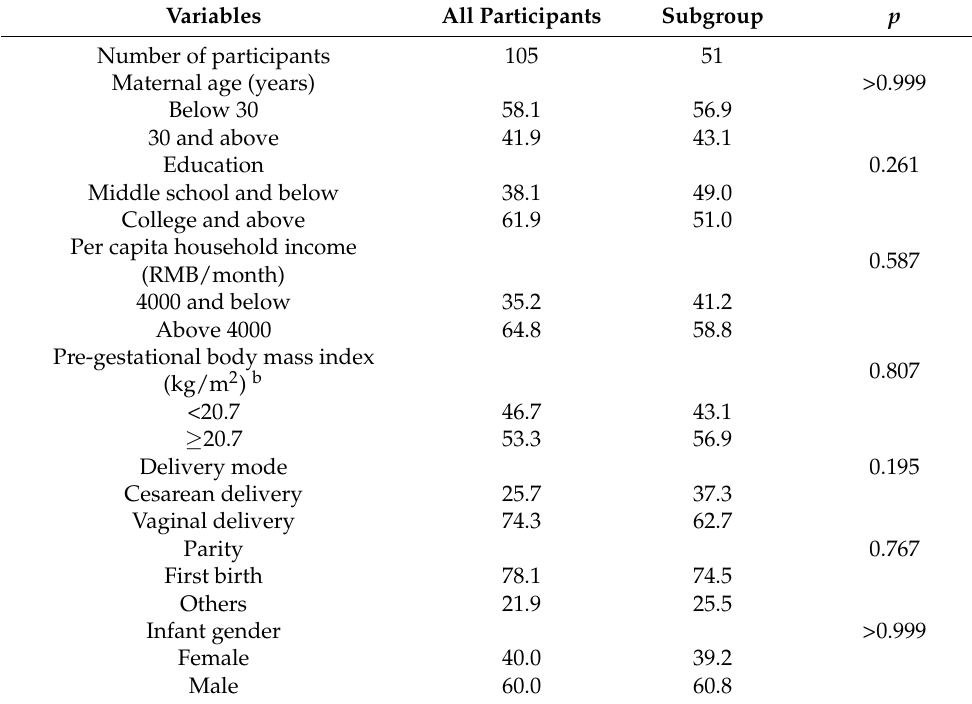
Table 1. Baseline characteristics of lactating mothers and corresponding infants a